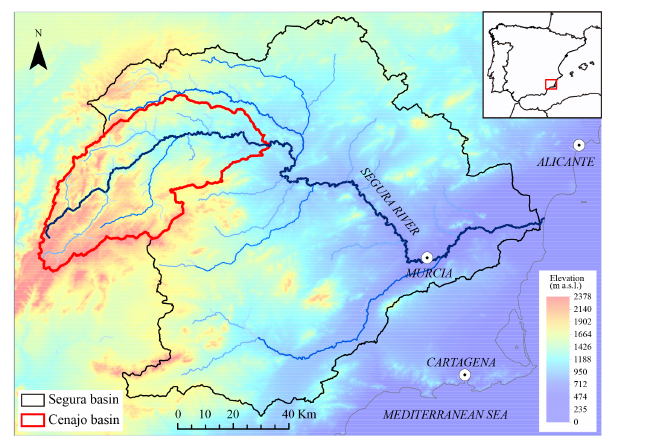
Figure 2. Location of the case study.